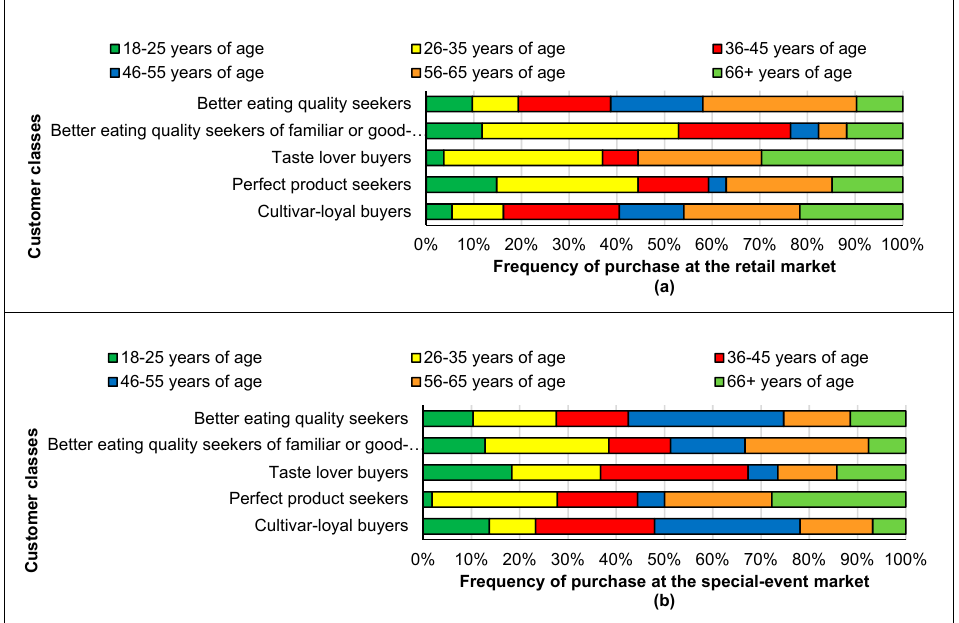
Figure 3. Age of the respondents in the different classes of consumers purchasing apples at the retail market ( a ) and special-event market ( b ).